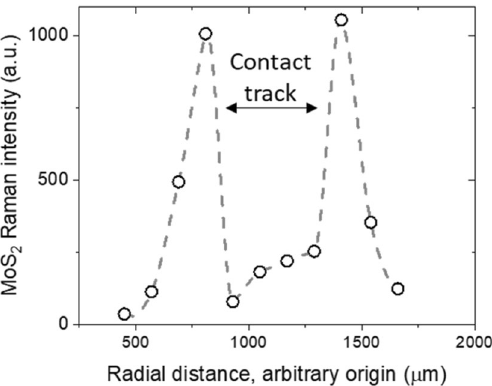
Figure 3. Typical radial MoS 2 intensity profile across a contact track measured after the test.